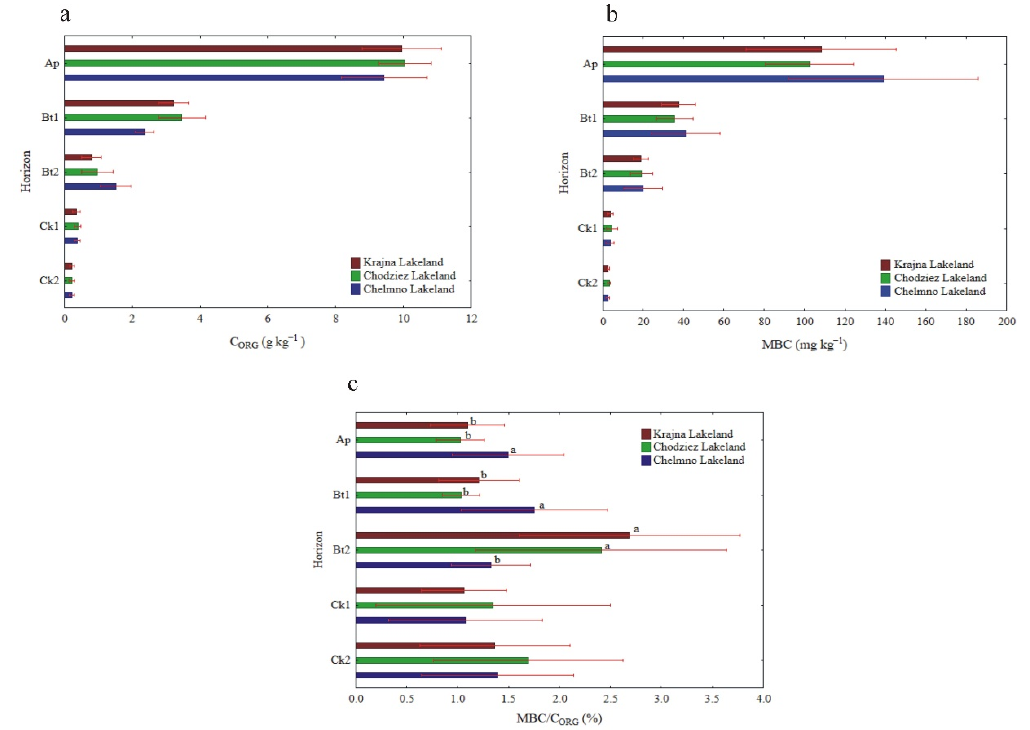
Figure 1. The content of C ORG ( a ), MBC ( b ) and MBC/C ORG ratio ( c ) at different soil depths (mean and SD). Different lowercase letters indicate significant differences ( p < 0.05) between study sites (within the same genetic horizons of the profile). C ORG —organic carbon; MBC—microbial biomass content.